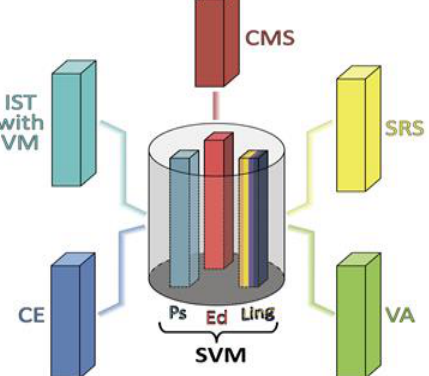
Fig. 10. E-AMS generalized structure.